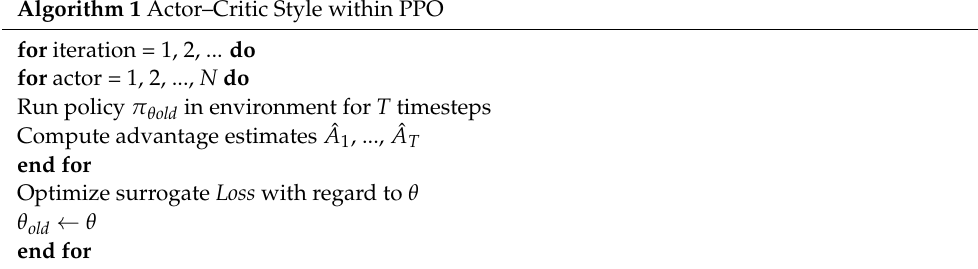
Algorithm 1 Actor–Critic Style within PPO